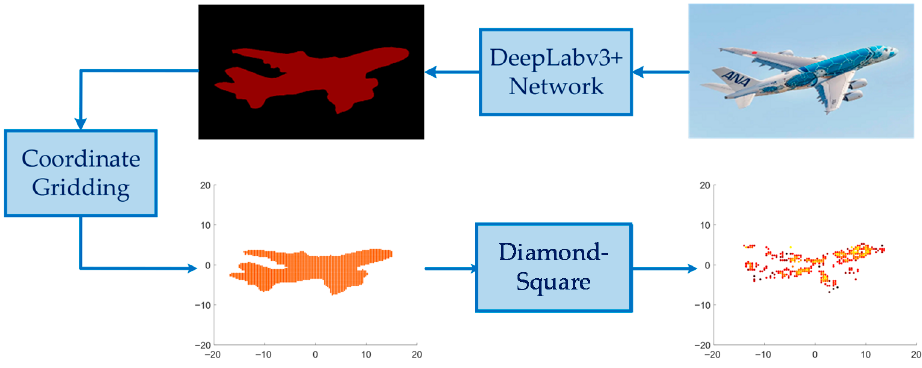
Figure 7. The generation process of pseudo-measured aircraft block targets.